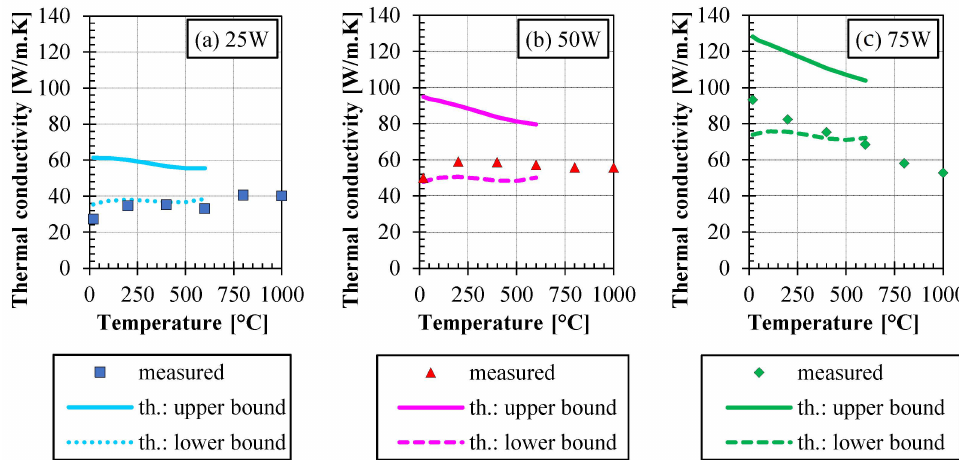
Figure 11. Measured and theoretically expected lower and upper bound values: ( a ) 25 W; ( b ) 50 W; and ( c ) 75 W